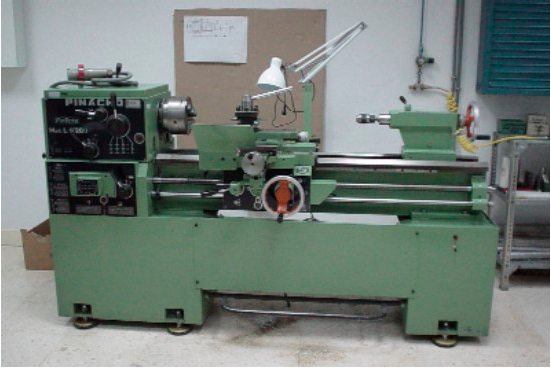
Figure 5. Pinacho Model L1/200 lathe.